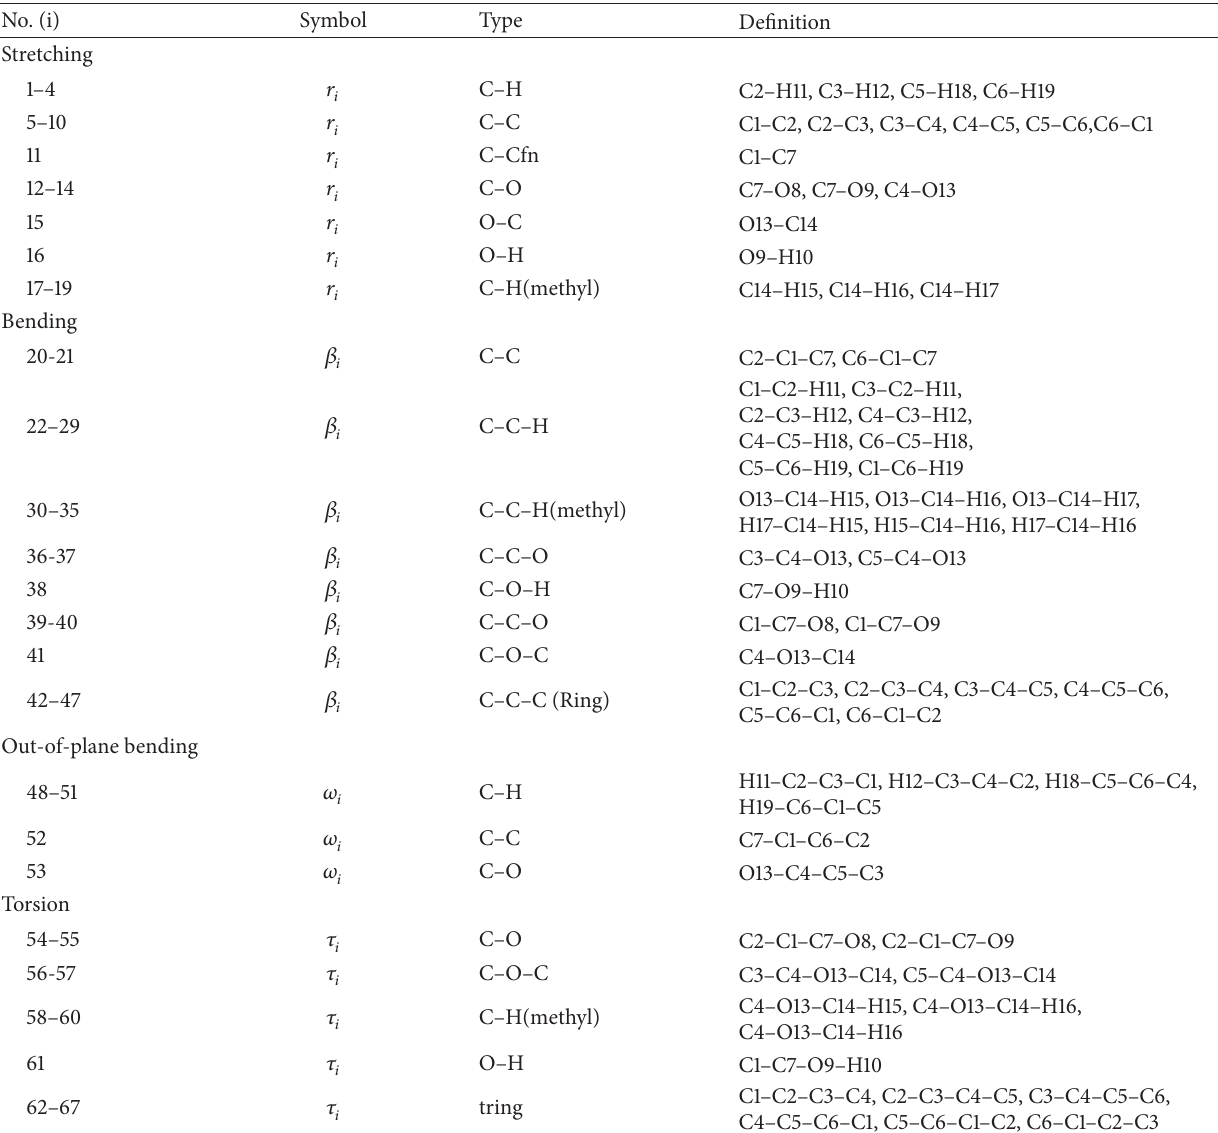
Table 3: Definition of internal coordinates of Anisic acid